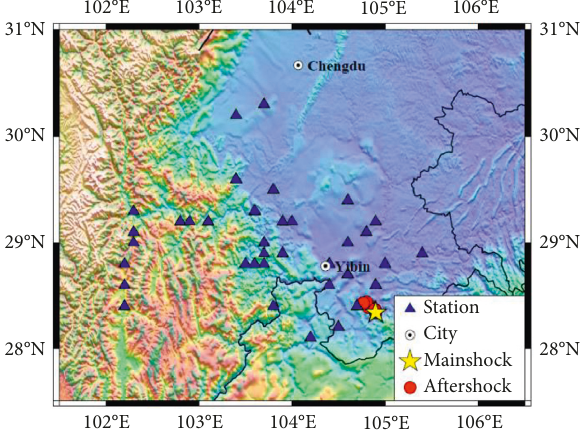
Figure 1: Map showing topography overlapped by the epicenters of the Changning earthquakes (yellow star) and aftershocks (red dot) and the locations of the stations used in this study.